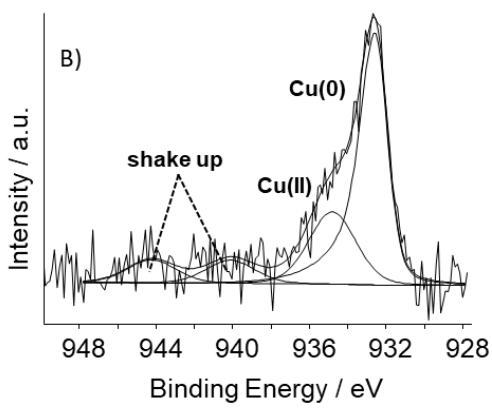
Figure 4. High-resolution photoelectron spectra of the Cu2p 3/2 core level of: ( A ) S_GA_FeCu; ( B ) S_GA_Cu.